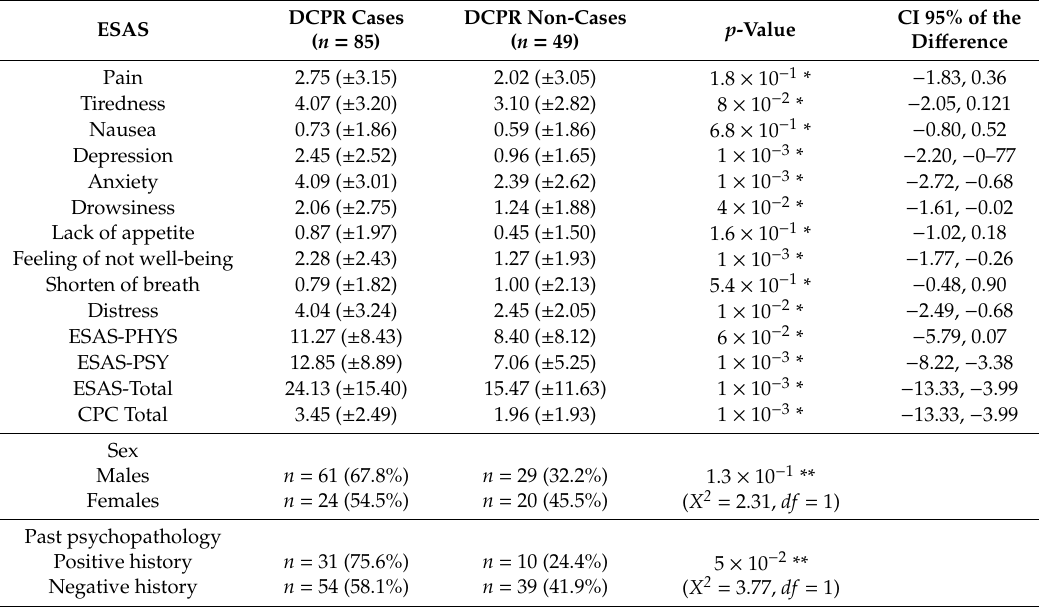
Table 3. Mean (SD) scores on the ESAS and clinical characteristics among DCPR groups.